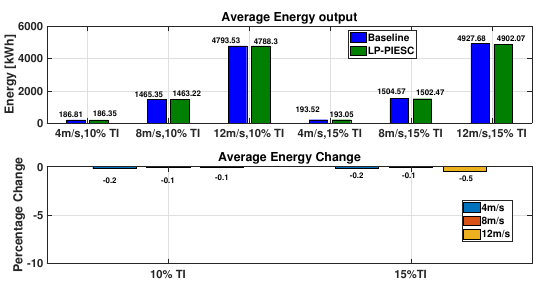
Figure 27. Energy capture comparison: Baseline vs. LP-PIESC. Average energy output with baseline optimal blade pitch angle and LP-PIESC ( top ), percentage change in energy capture ( bottom ).